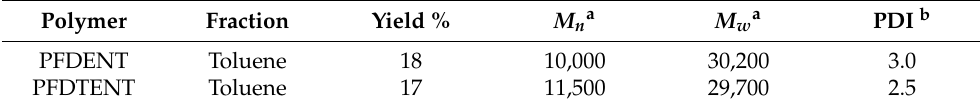
Table 1. GPC data of PFDENT and PFDTENT .